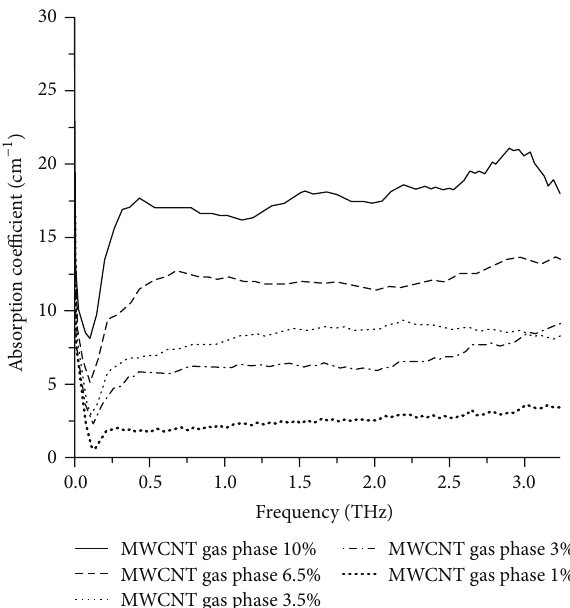
Figure 2: Carbon multilayer nanotubes (gas-phase technology made) absorption spectra changes with the increasing of their concentration in a plastic bag, %